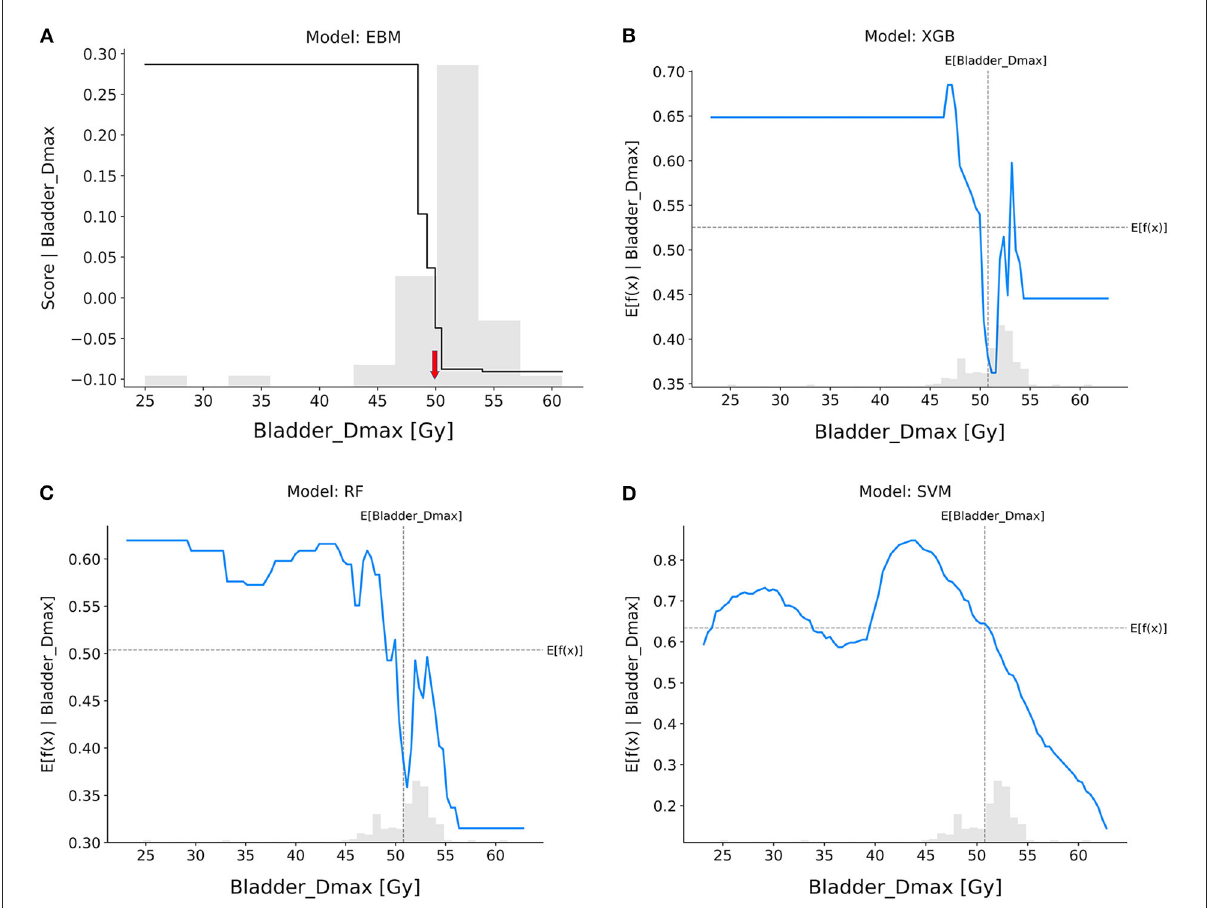
FIGURE6 Response score plots for bladder_Dmax. (A) EBM shape function and SHAP partial dependence functions for the (B) XGB, (C) RF, and (D) SVM